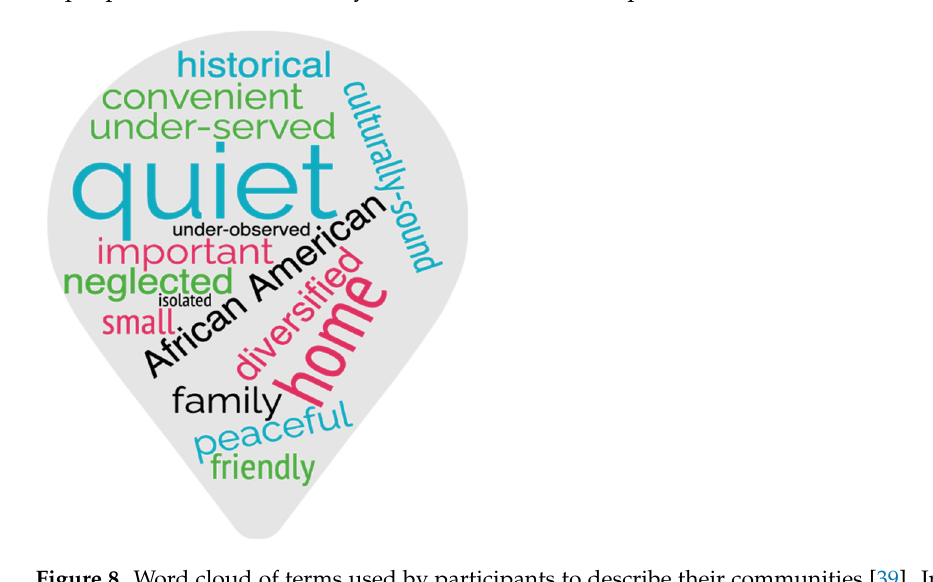
Figure 8. Word cloud of terms used by participants to describe their communities [39]. Interview sample size was low, so frequencies are not assumed to be generalizable to all Neck